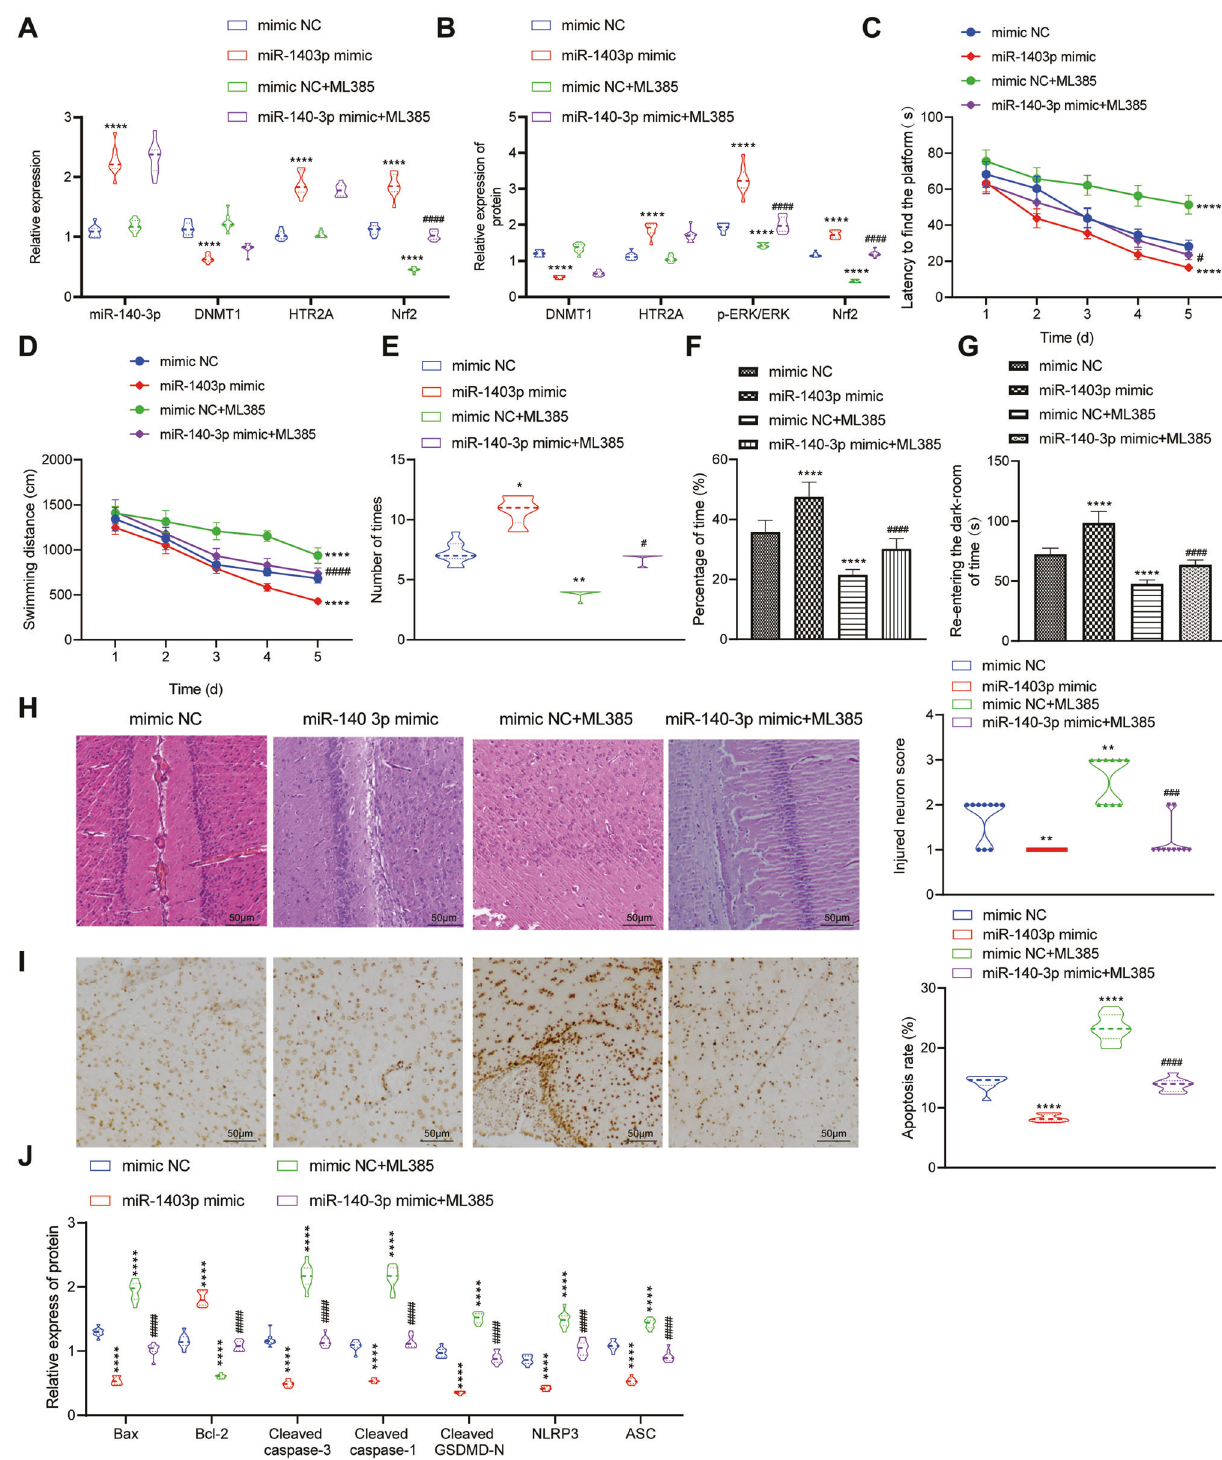
Fig. 7 miR-140-3p modulates the DNMT1/HTR2A/ERK/Nrf2 axis to attenuate Sevo-induced POCD in rats. POCD rats were treated with mimic NC, miR-140-3p, mimic NC + ML385, or miR-140-3p + ML385. A The detection of expression of miR-140-3p, DNMT1, HTR2A, and Nrf2 in the hippocampal tissues of rats by RT-qPCR. B The detection of protein levels of DNMT1, HTR2A, and Nrf2 and phosphorylated ERK/total ERK protein expression ratio through Western blot analysis. C Time for rats to fi nd hidden platform in water maze. D Swimming distance of rats before fi nding the hidden platform in water maze. E The times of rats crossing hidden platform in water maze. F The residence time ratio of rats on the hidden platform of water maze. G The time for rats to re-enter the darkroom in the step-through test. H H&E staining to determine the pathological changes of hippocampal tissues. I TUNEL staining to detect the apoptosis of hippocampal neurons in rats. J Western blot analysis to detect the protein expression of apoptosis- and pyroptosis-related factors in hippocampal tissues of rats. There were ten rats in each group. * p < 0.05, ** p < 0.01, and *** p < 0.001 vs. the rats treated with mimic NC; # p < 0.05, ## p < 0.01, and ### p < 0.001 vs. the rats treated with miR-140-3p mimic. Cell Death Discovery (2022)